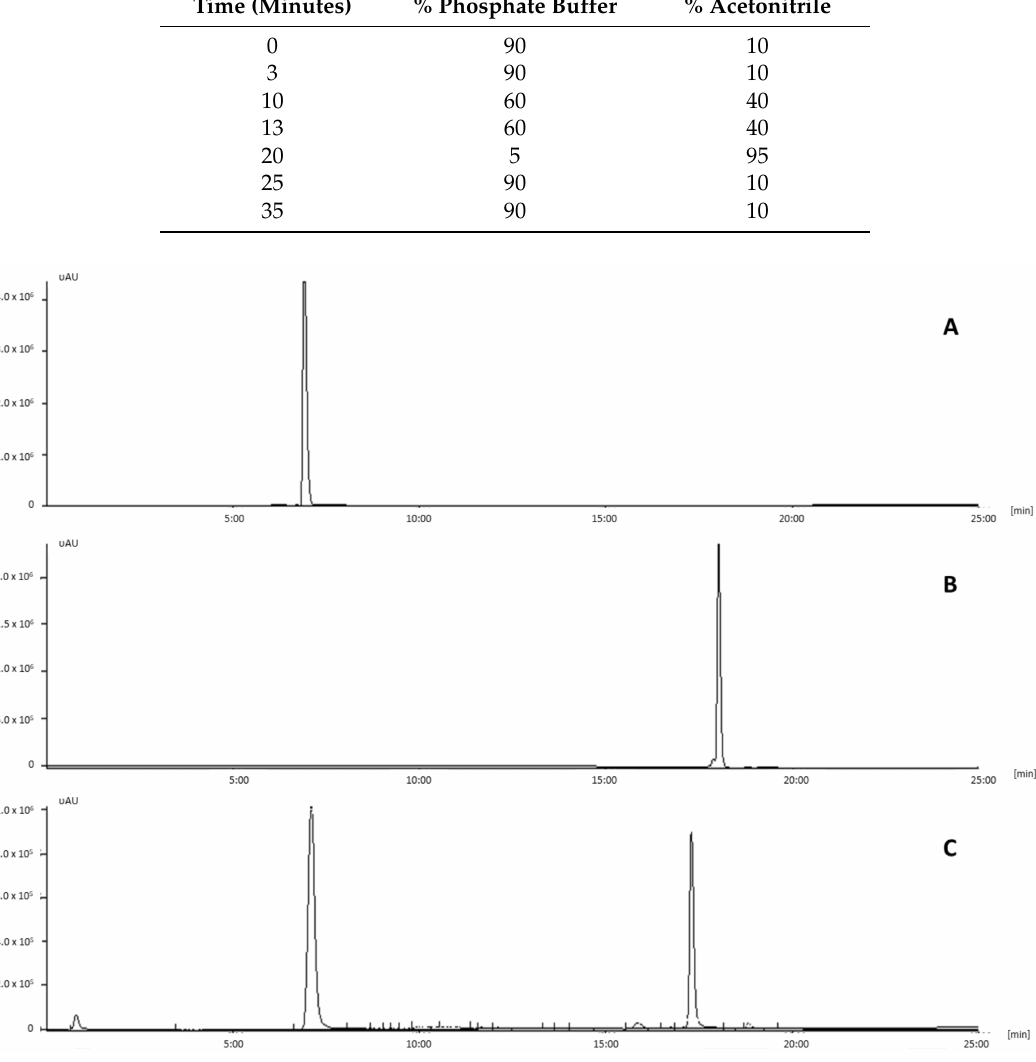
Figure A1. ( A ) Acetophenone (RT: 6.8 min); ( B ) compound 1a (RT: 16 min); ( C ) reaction mixture (MW) acetophenone (2.0 eq.), 4-benzylpiperidine hydrochloride (1 eq.), paraformaldehyde (1